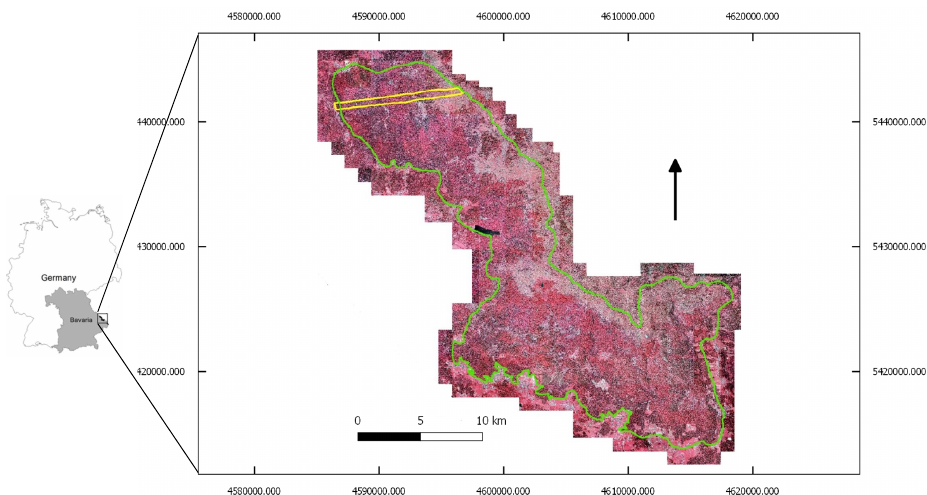
Figure 1. Color infrared orthophoto of the Bavarian Forest National Park (park border in green, transect border in yellow.